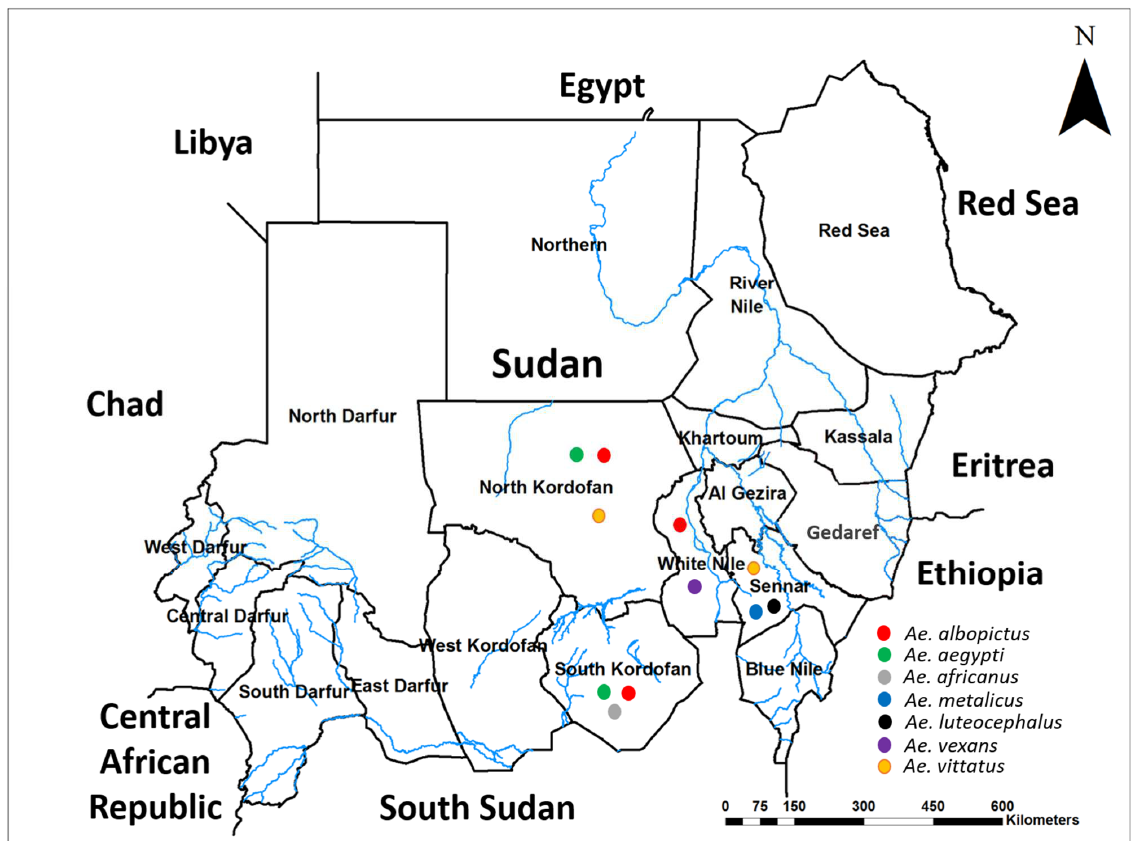
Figure 1. Map of Sudan showing the geographical distribution of identified Aedes mosquitoes in the study area.